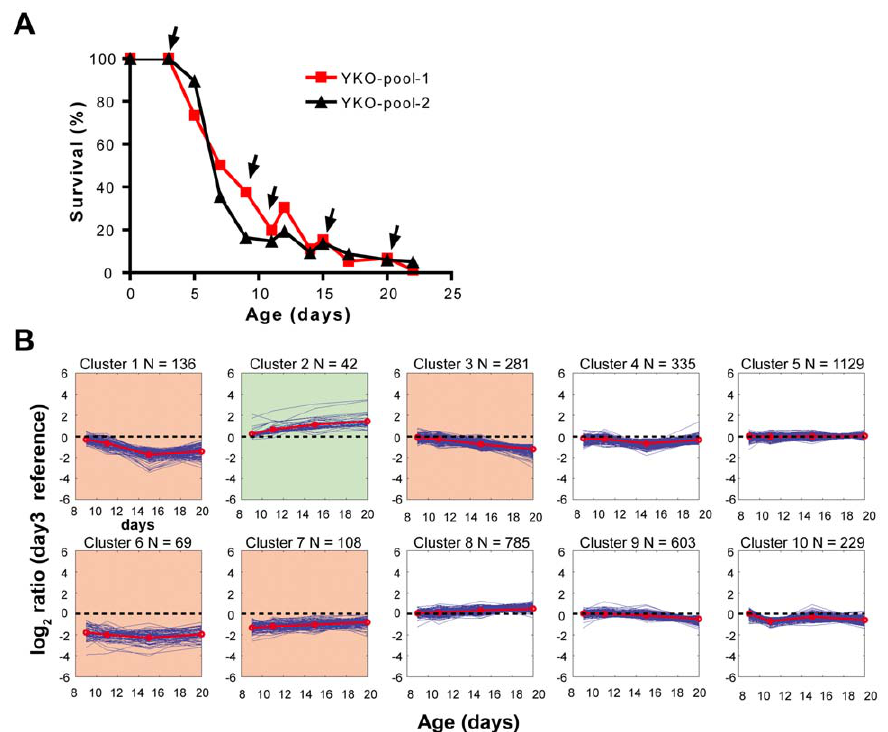
Figure 1. Screen of the yeast homozygous deletion collection for life span regulatory genes. (A) CLS of the two pools used for the yeast deletion collection screen. The black arrows indicate when cell samples were collected for DNA extraction. The experiment was conducted by incubating the yeast pools in SDC medium throughout the experiment. (B) 10 aging profile clusters derived by K-means clustering analysis. The y-axis displays the log 2 fold ratio of tag intensity for each strain at each time point relative to the day 3 time point. Plots highlighted in red represent clusters classified as short-lived and the plot highlighted in green represents a cluster classified as long-lived. The dashed black line demarcates the boundary between short and long-lived strains. The red line is the centroid (average profile) for each cluster.